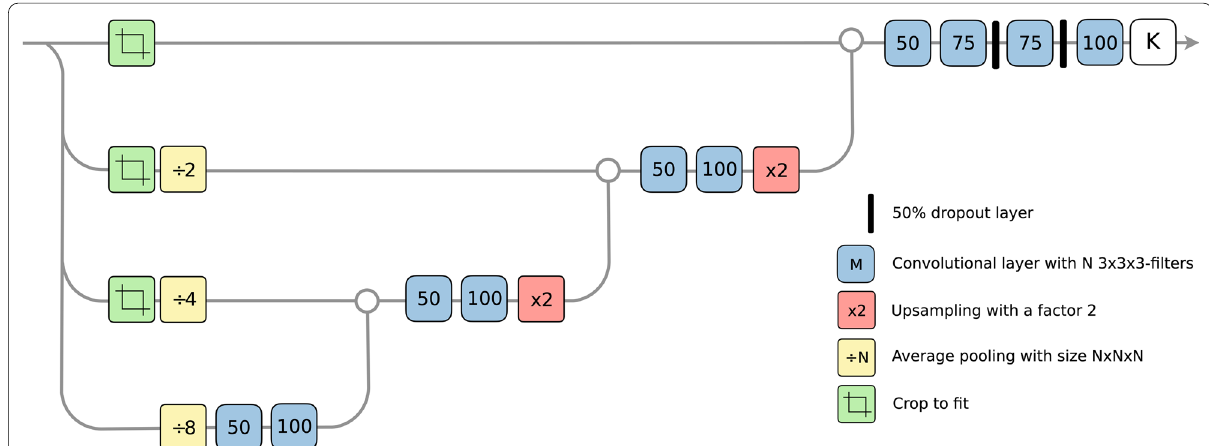
Fig. 1 Architecture of CNN used to segment lungs and liver. Convolution layers do not use padding. Input shape to network is 72 cube; output shape is 8